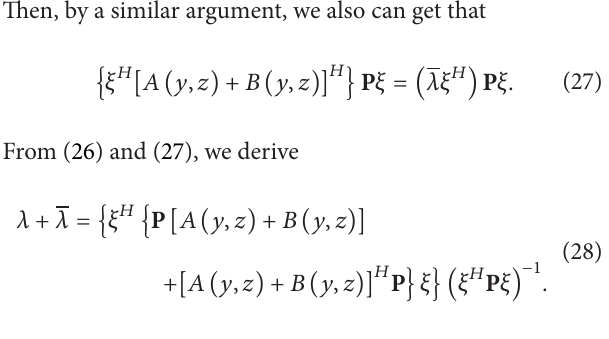
Figure4:Thebifurcationdiagramofthesystem(14)withparameter 𝑏 ∈ [10, 125] .